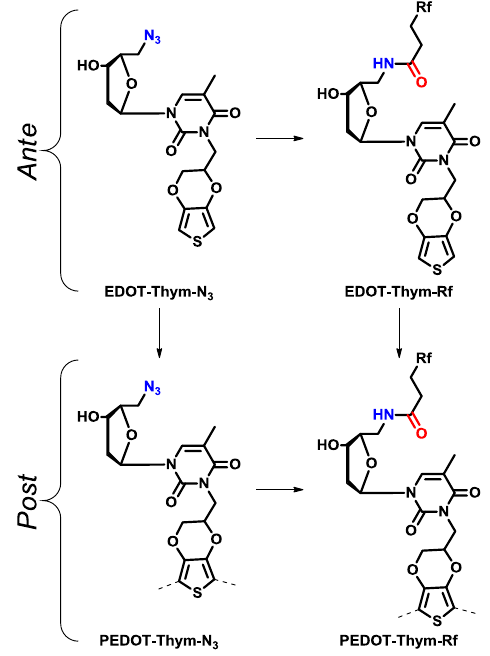
Figure 1. General procedure for surface elaboration.